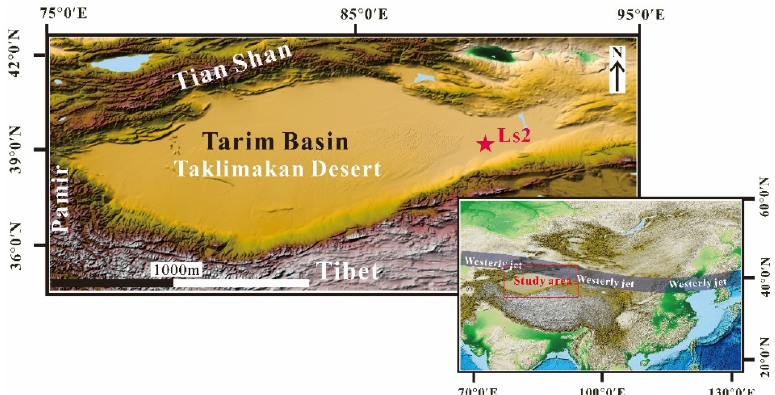
Figure 1. Location map of drill core Ls2 and the westerly